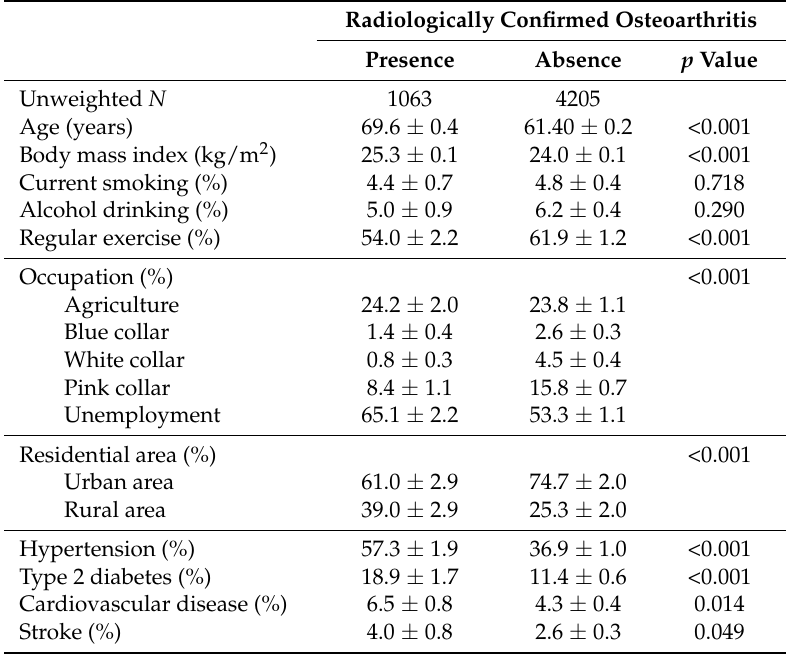
Table 1. Clinical characteristics in the study population.